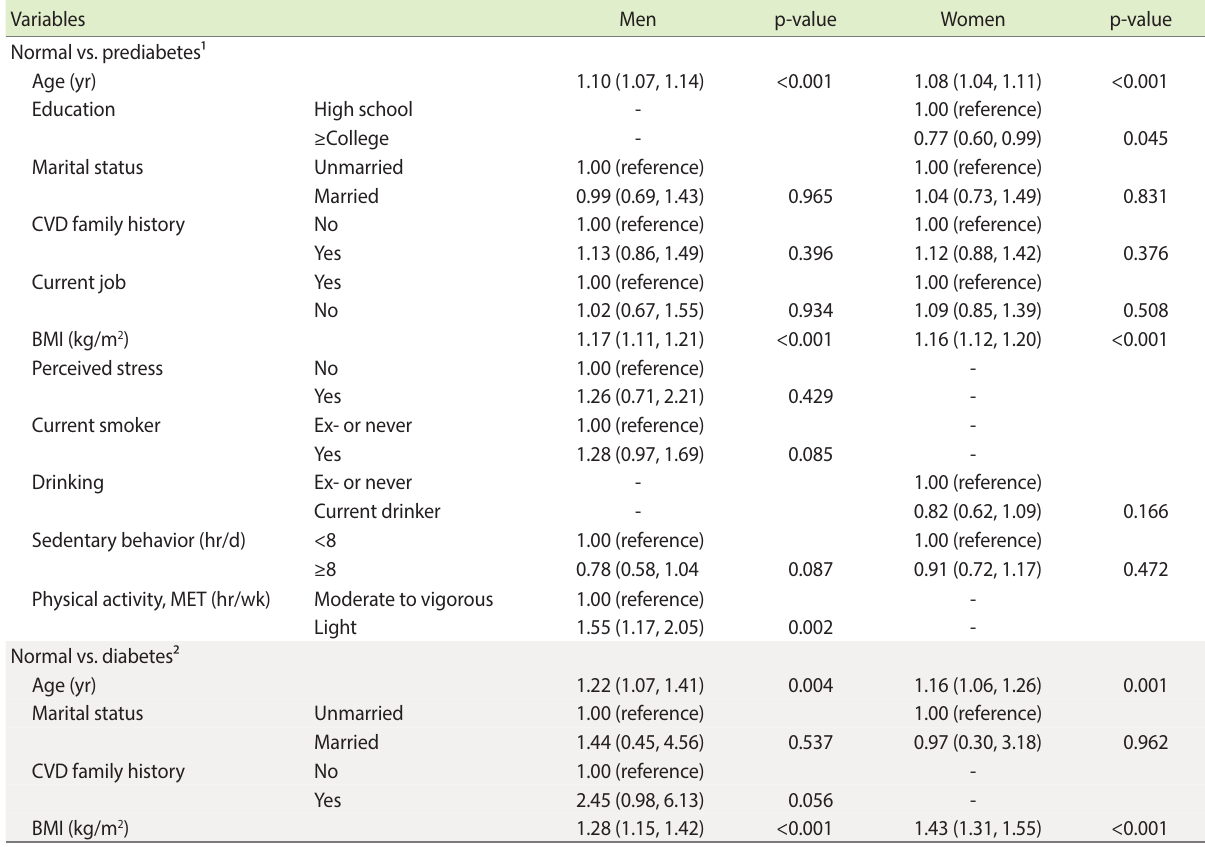
Table 5. Comparison of lifestyle predictors affecting prediabetes and diabetes group compared to normal group by gender